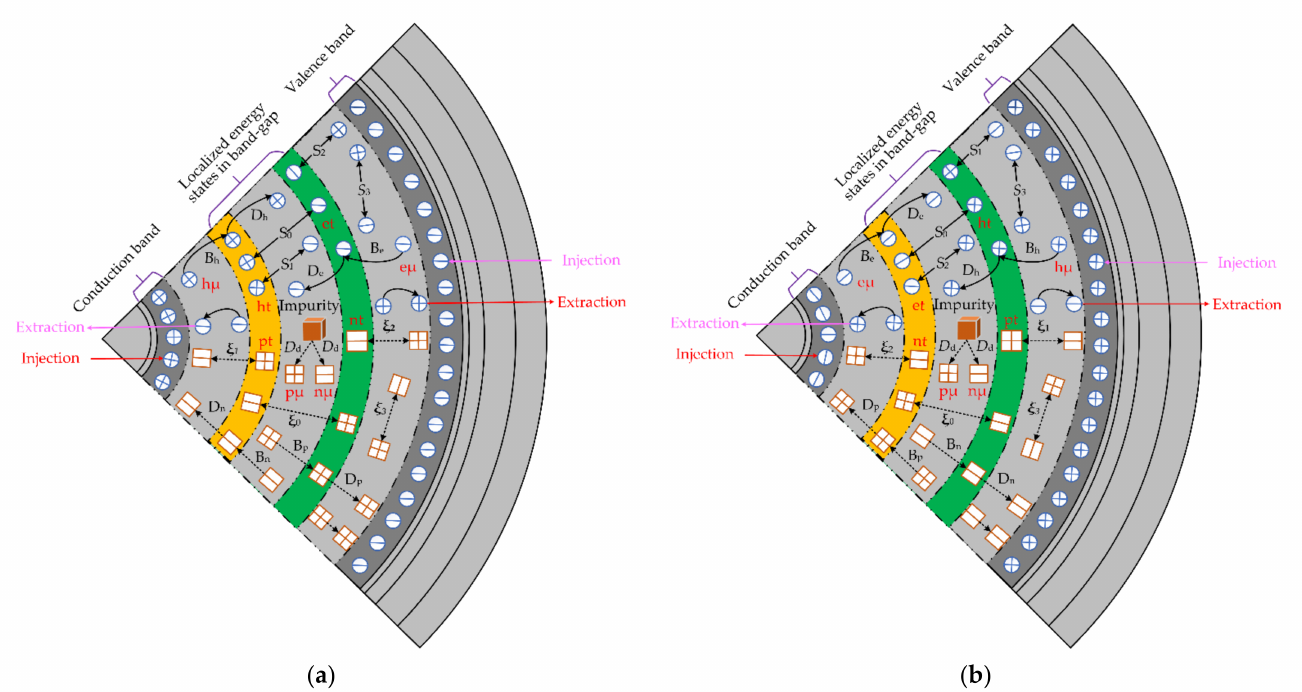
Figure 13. Mechanism model of space charge generation and transport in the HVDC extruded cable under VPR: ( a ) Before the VPR; ( b ) After the